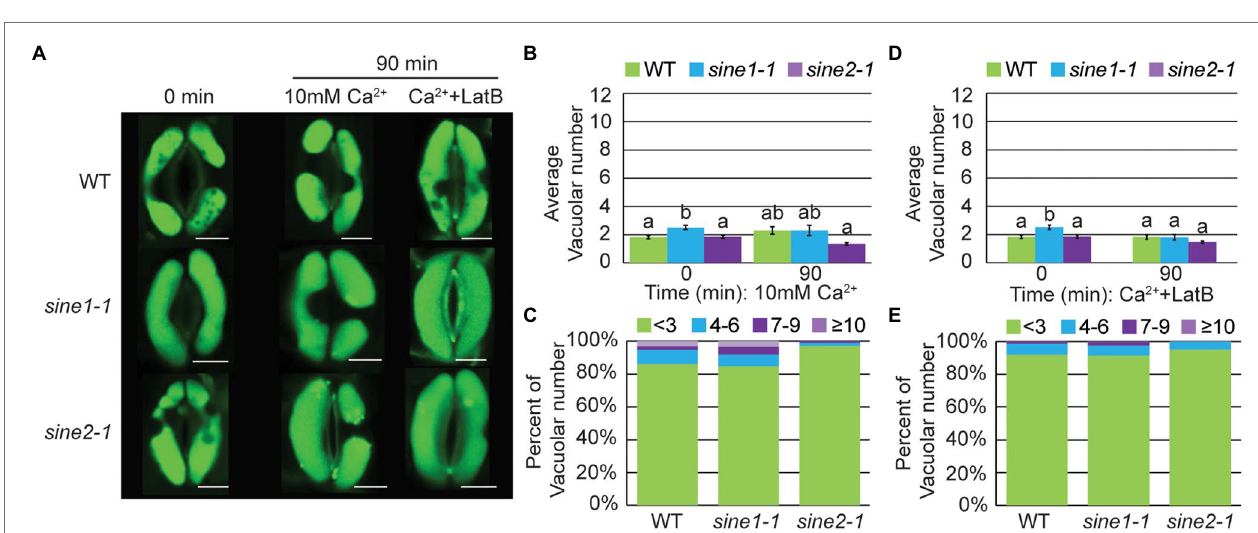
FIGURE 7 | Vacuolar fragmentation does not occur during Ca 2+ -induced stomatal closure, regardless of changes to actin organization. (A) Representative images of vacuolar morphology at 0 and 90 min after addition of either 10 mM Ca 2+ or 10 mM Ca 2+ + 10 μ M LatB. Scale bars = 5 μ m. (B,D) Average vacuolar number seen in guard cells before and after treatment with (B) 10 mM Ca 2+ or (D) 10 mM Ca 2+ + 10 μ M LatB. Statistical significance was calculated using one-way ANOVA followed by a post hoc Tukey HSD test. Lowercase letters denote groups that are statistically different ( p < 0.01). Data are mean values ± SE from three independent experiments. The number of stomata analyzed for each line is ≥ 68 guard cells. (C,E) Distribution of distinct vacuolar structures observed in guard cells after 90 min of treatment with either (C) 10 mM Ca 2+ or; (E) 10 mM Ca 2+ + 10 μ M